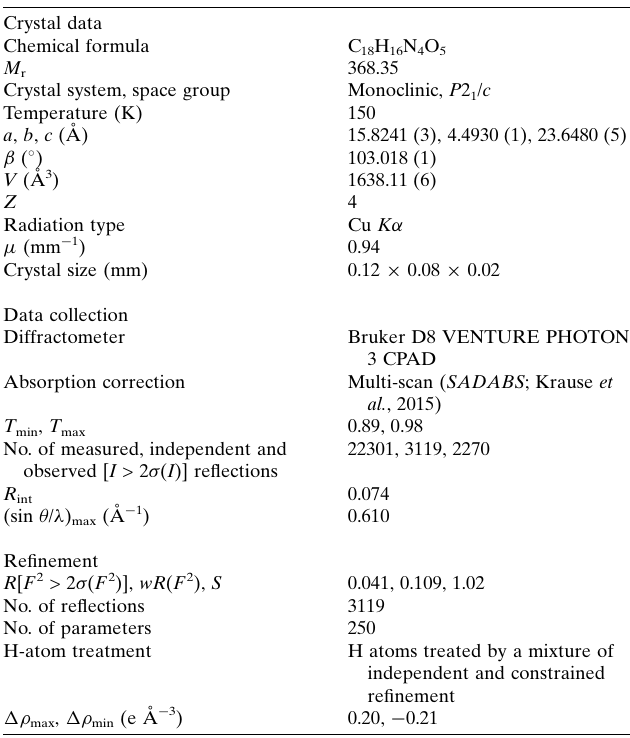
Table 2 Experimental details.